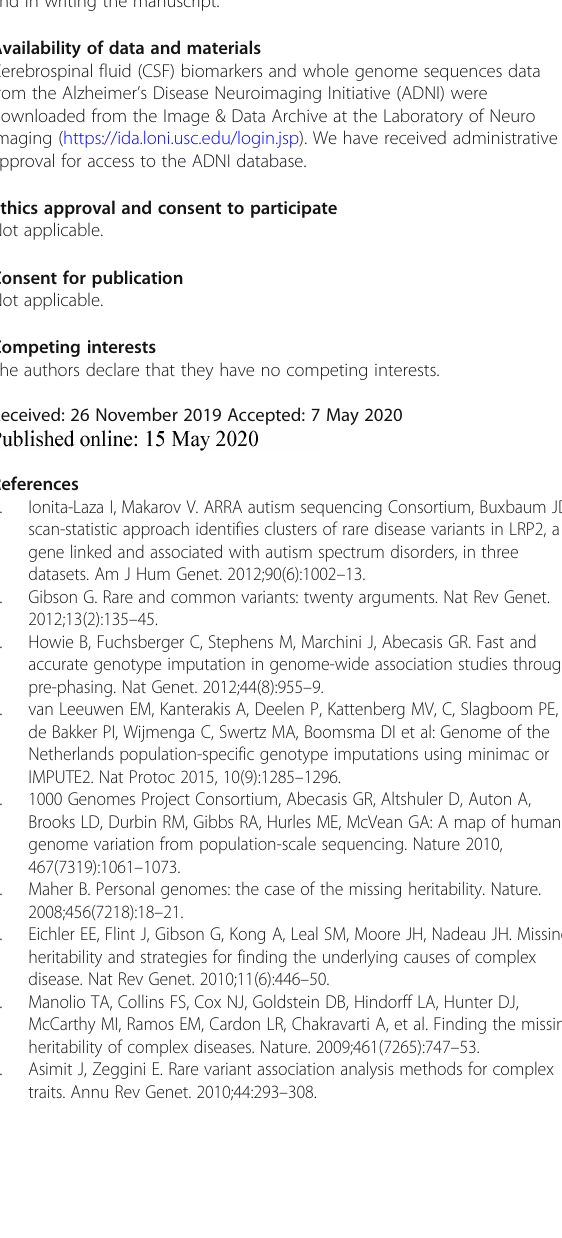
Figure S23 . QPSS p-values computed by the permutation with general- ized Pareto distribution approximation for the associations between